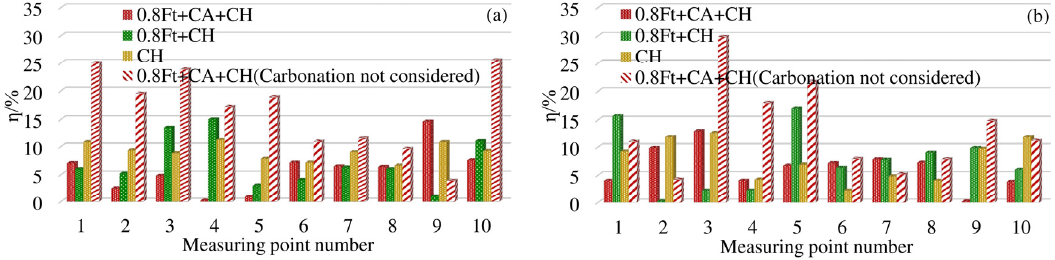
Figure 8. ƞ of chloride concentration at each measuring point of the test box girder: ( a ) ƞ at 4 mm; ( b ) ƞ at 7 mm.